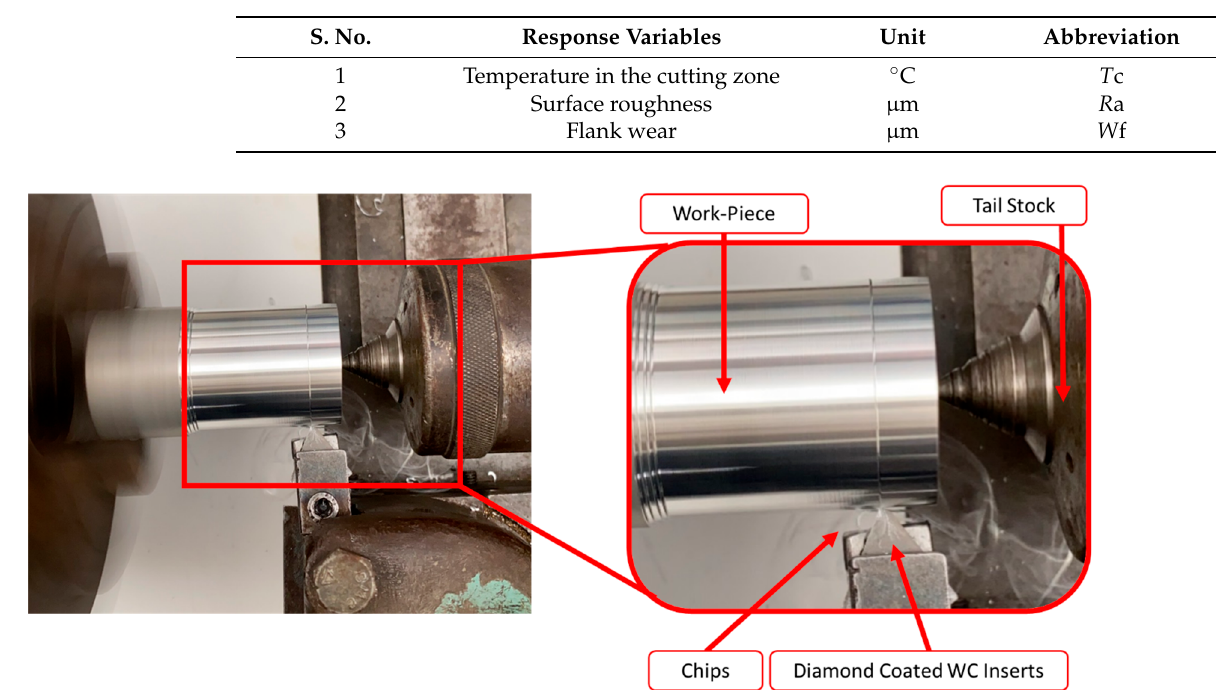
Figure 2. Turning process using self-developed DLC-coated tungsten carbide (WC) tool insert.